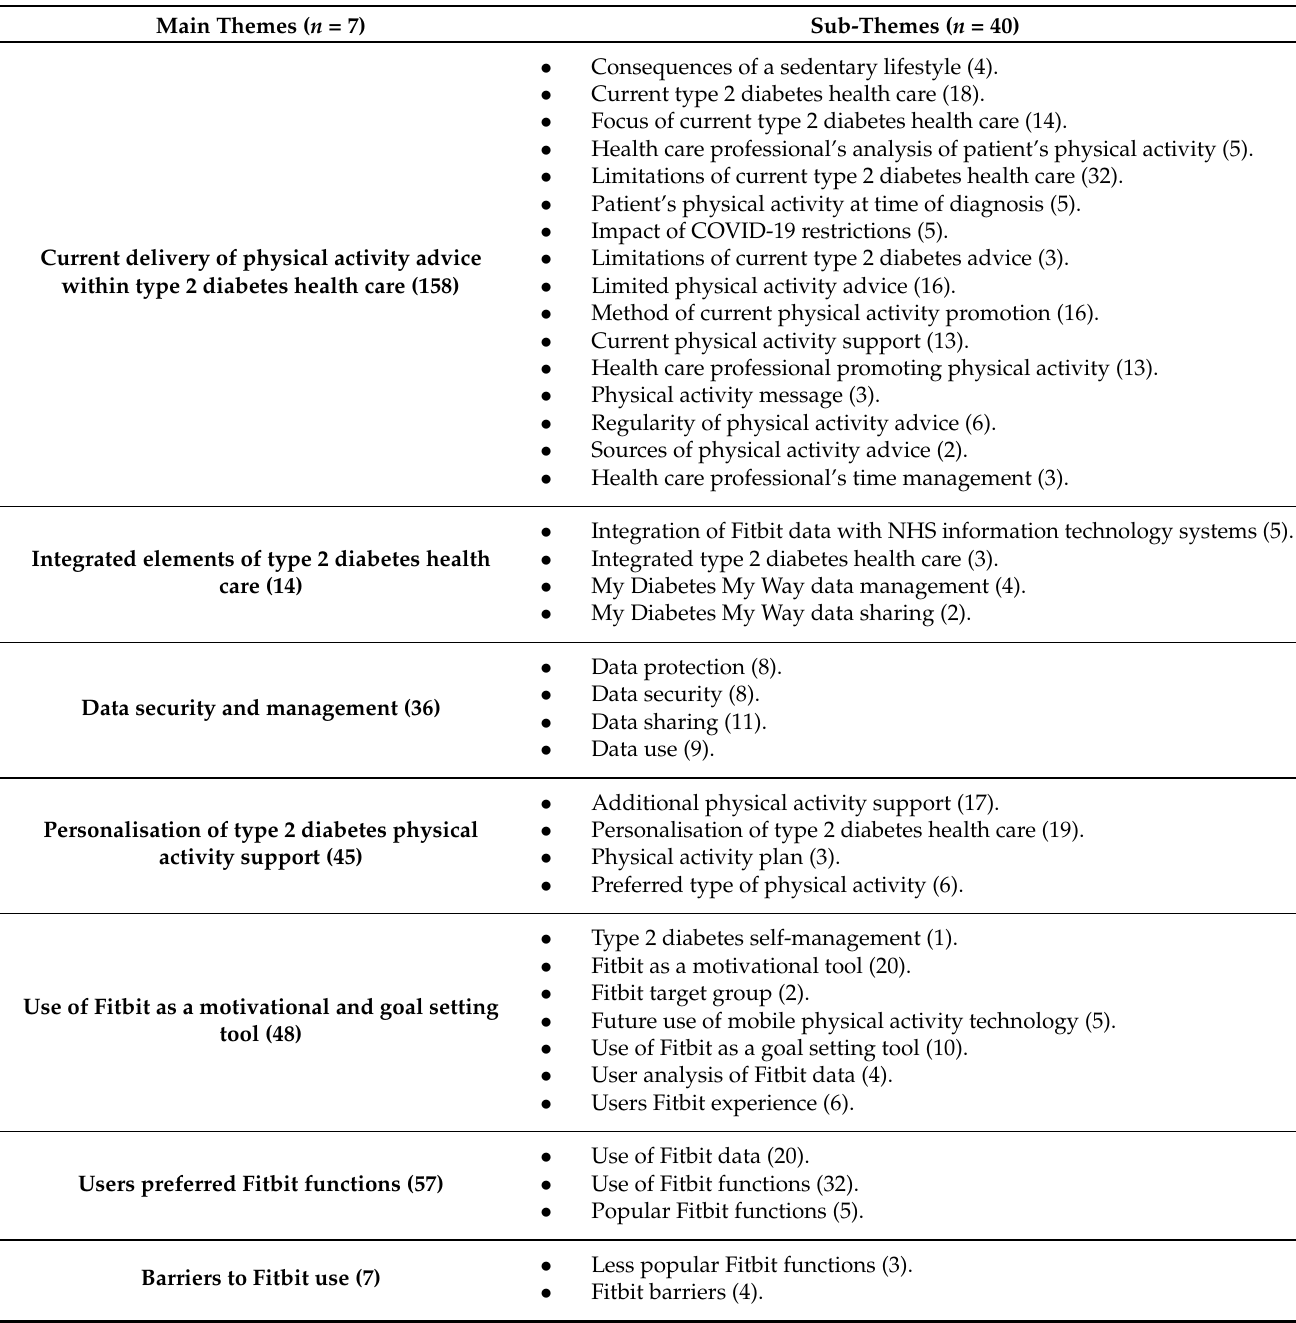
Table 2. Identified main themes and associated sub-themes with the number of in-text references displayed in brackets. Main Themes ( n =